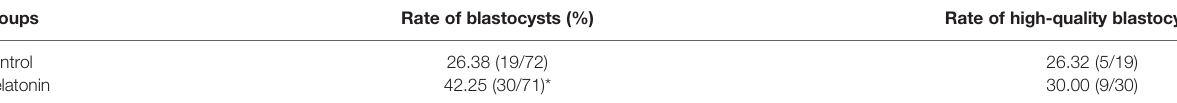
TABLE 5 | Effect of melatonin on the in vitro development of 143 vitri fi ed-warmed human cleavage-stage embryos.